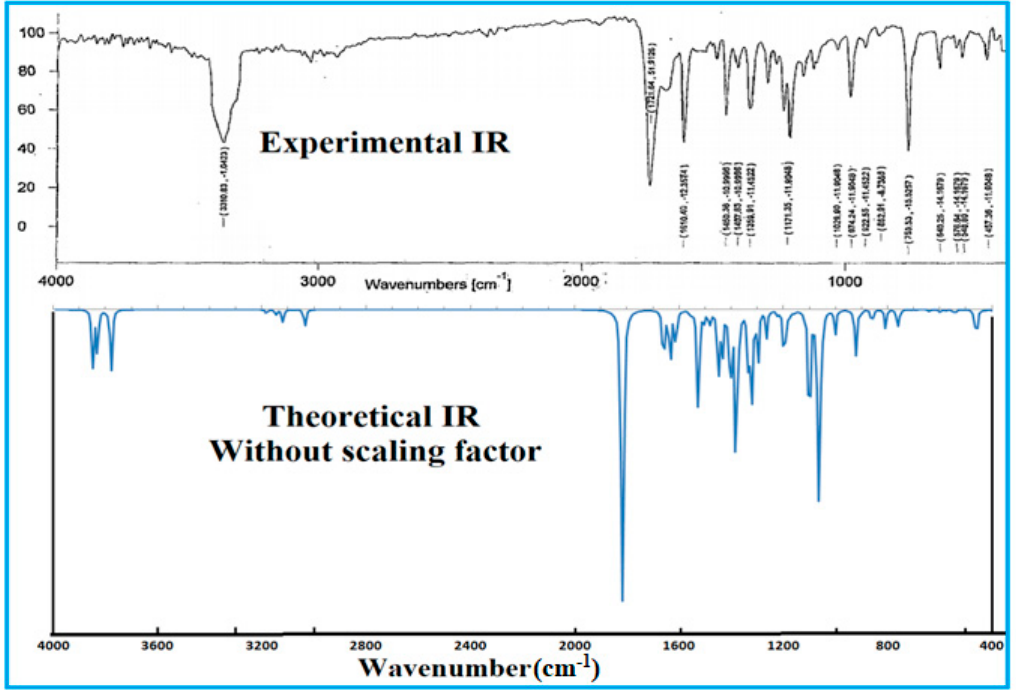
Figure 5. Theoretical and experimental IR spectra of compound 2